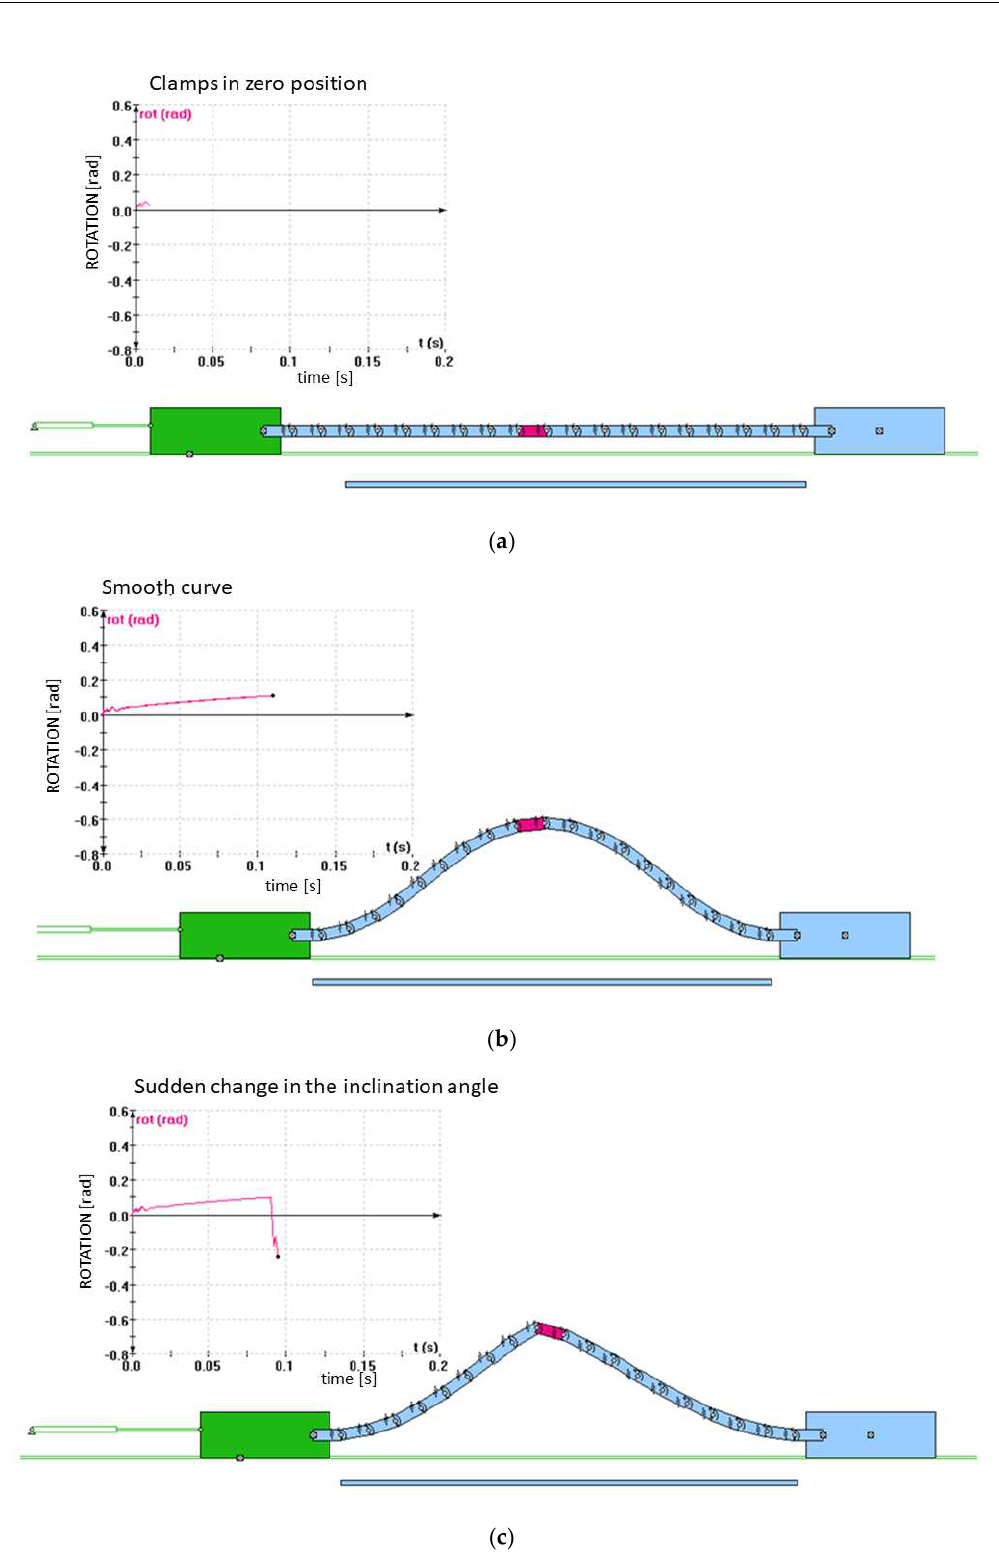
Figure 12. The simulated progress of textile buckling of the discretized model of the investigated textile laminate sample in the Working Model 2D program environment at a clamp distance of 110 mm: ( a ) the starting position; ( b ) the buckling without the loss of shape stability; ( c ) the loss of shape